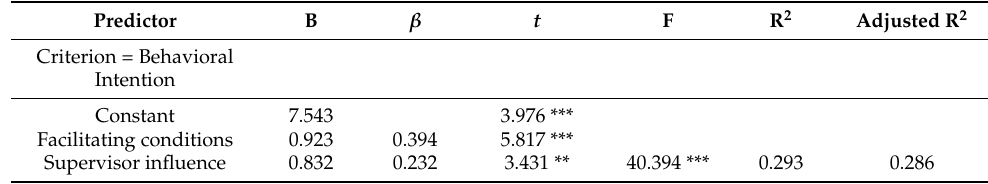
Table 5. Summary table of multiple regression analysis of behavioral intention predictors. Predictor B